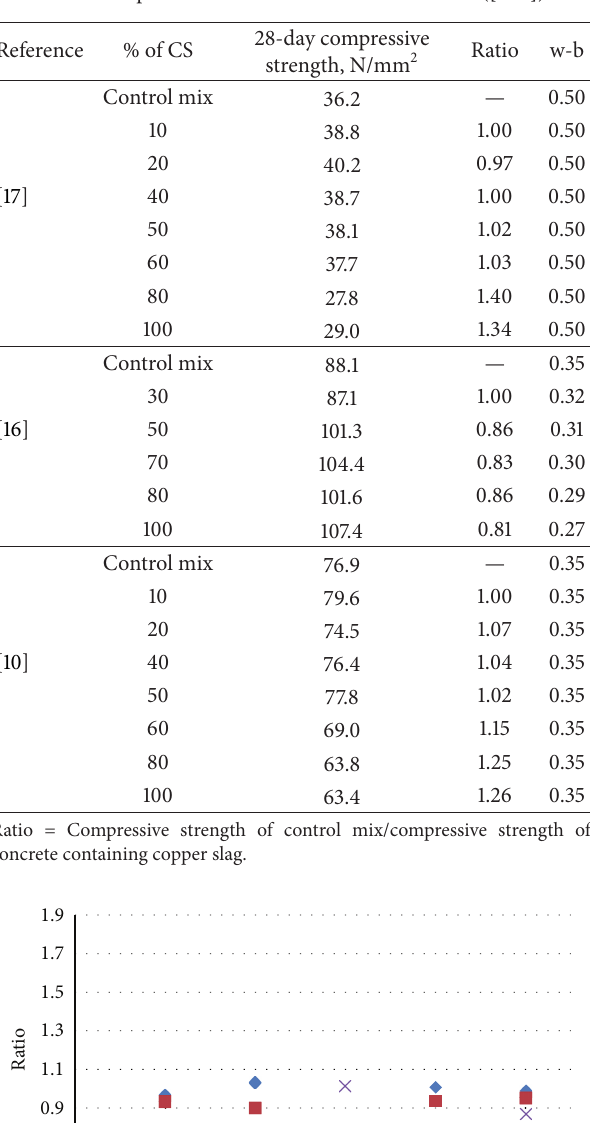
Table 5: Experimental results from the references ([6–8]).